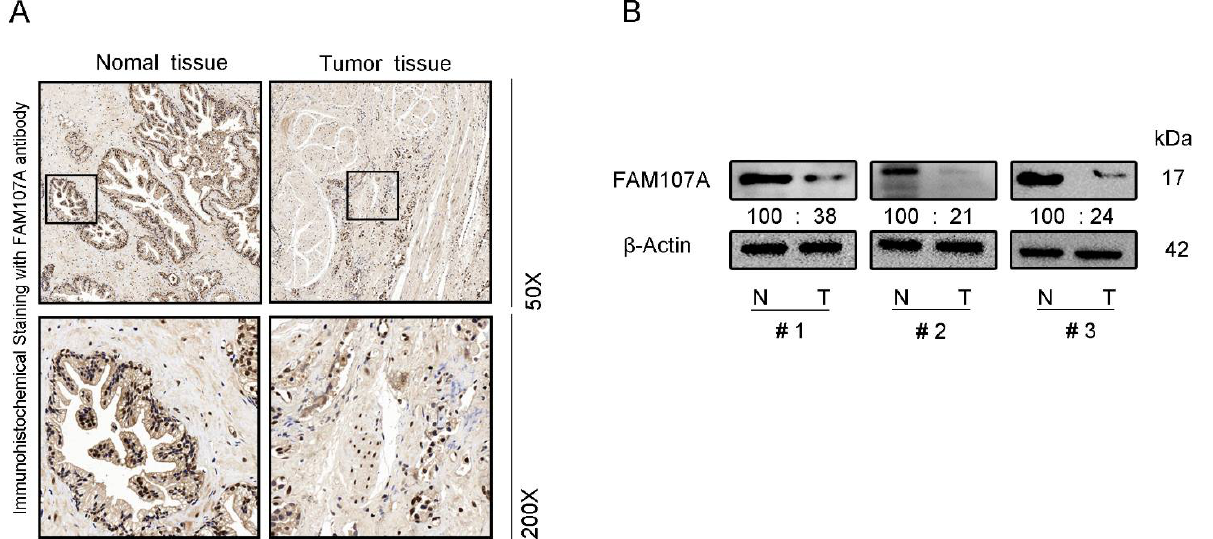
Figure 2. FAM107A expression was higher in normal prostate tissues than in prostate cancer tissues. ( A ) Measurement of protein levels of FAM107A in normal and prostate cancer tissues by immuno- histochemical analysis. Representative images were shown at magnifications of 50× and 200×, re- spectively. ( B ) Protein levels of FAM107A in normal and prostate cancer tissues by Western blotting.